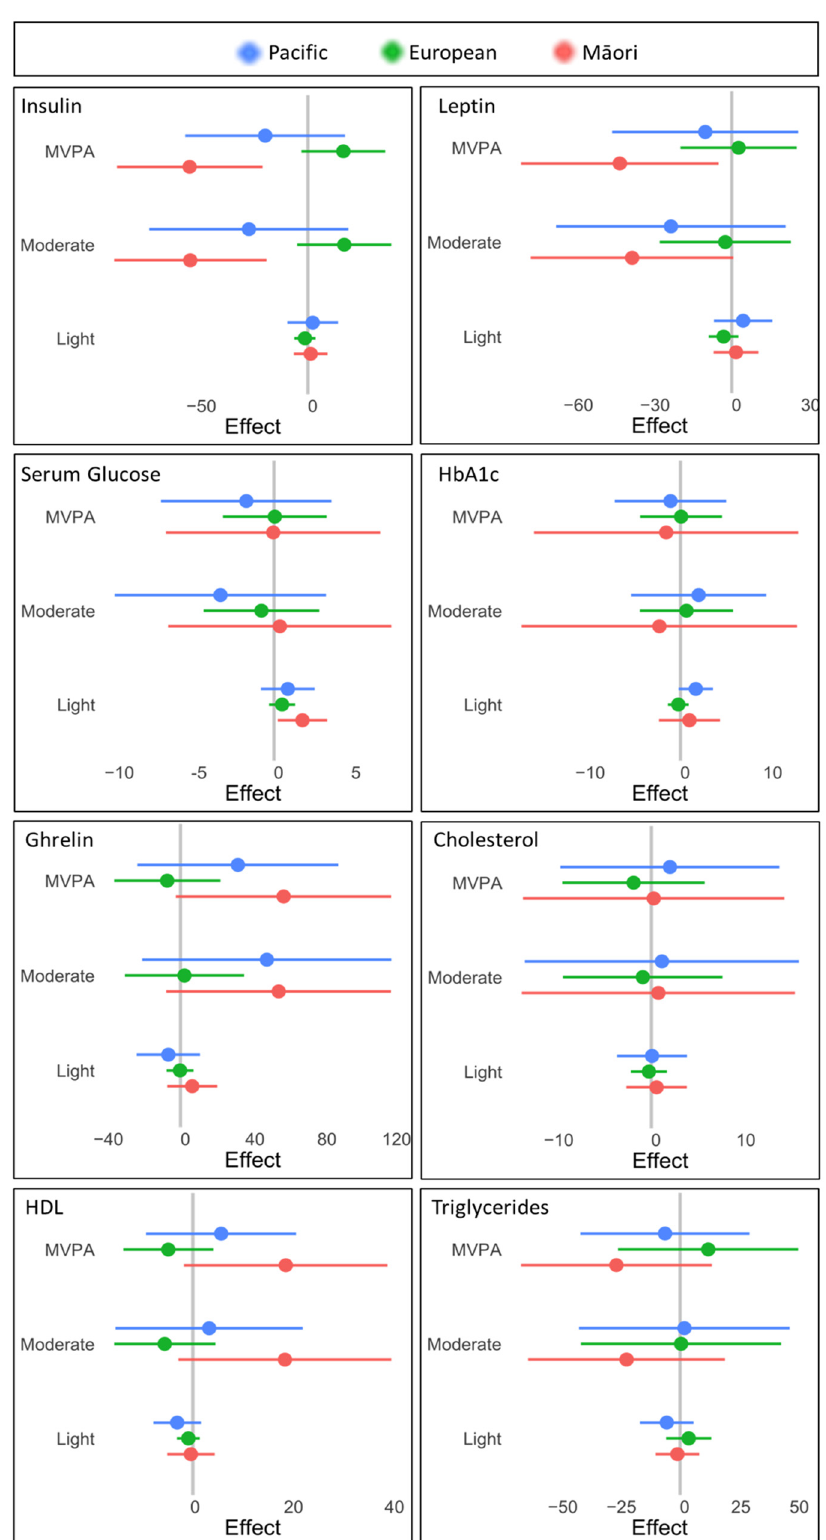
Figure 2. Reallocation effects across metabolic markers. 95% confidence intervals for magnitude of predicted change in metabolic markers when sedentary behaviour is reallocated for physical activity at light, moderate, and moderate-to-vigorous (MVPA) intensities. Participants are sub-stratified by ethnicity: Pacific (blue), European (green), and M ā ori (red).